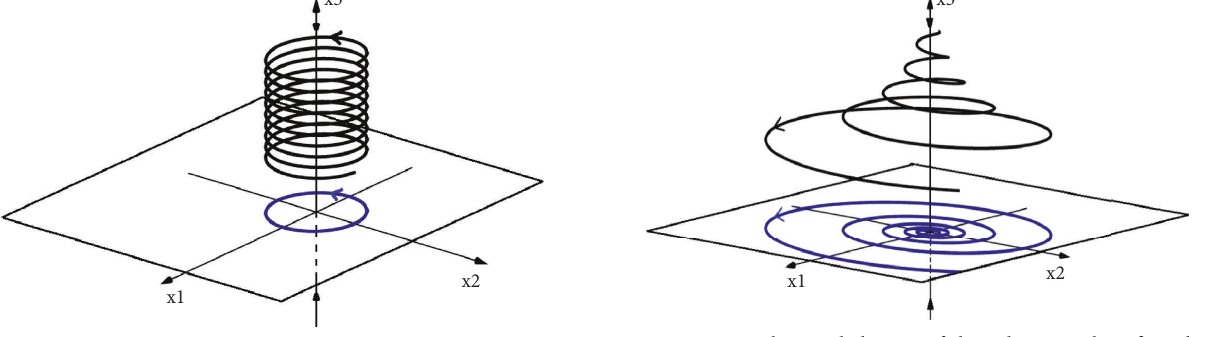
Figure 1: Qualitative behavior of the solutions when β � 1/ h .